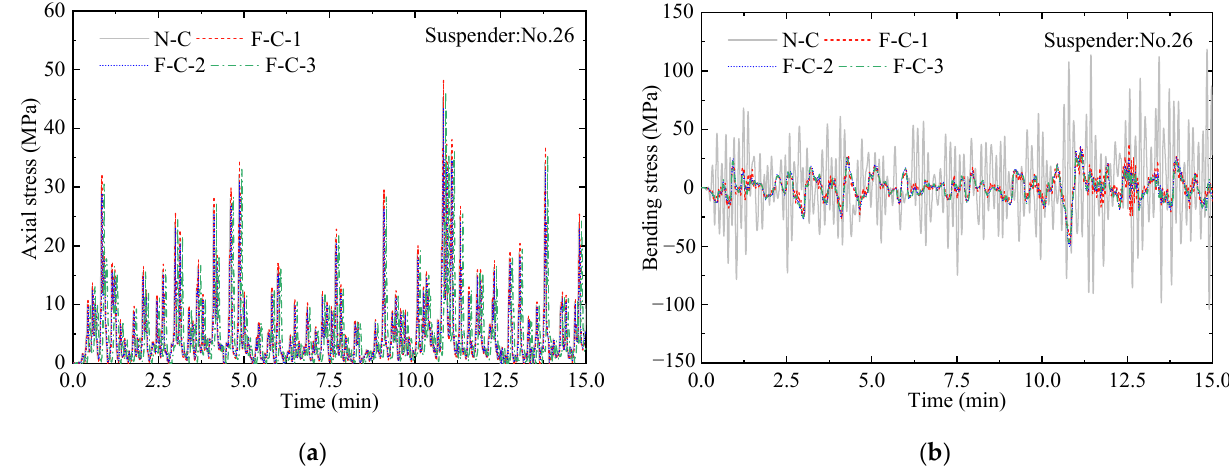
Figure 13. Time history of suspender stress (level 5). ( a ) Axial stress; ( b ) bending stress. Figure 14 shows the peak values of bending stress and axial stress. The suspender stress response under different traffic flows is different, and the axial stress is slightly in- fluenced by different traffic flows, whereas the bending stress is greatly reduced by flexi- ble central buckles. The settlement of flexible central buckles has a certain influence on the axial stress and bending stress of short suspenders. The axial stress peak values vary un- der different conditions. F-C-1 has an improvement effect on suspender no. 26, whereas F-C-2 has an improvement effect on suspender no. 25; these results are related to the po- sition of buckles. The settlement of buckles shares the axial stress of the suspender be- tween inclined cables. In terms of bending stress, the flexible central buckle can remarka- bly reduce the peak value of short suspenders, but the weakening effect is not significantly improved with the increase in the number of buckles. ( a ) ( b ) Figure 14. Comparison of peak values of stress. ( a ) Axial stress; ( b ) bending stress. The generation of pitting corrosion is a random process, and the maximum pitting depth directly affects the generation of cracks and fatigue life. In order to reflect the dif- ference in steel wire life, the corrosion fatigue degradation of steel wire under different working conditions was simulated. A total of 150 samples for each analysis condition were sampled based on randomly generated maximum pitting coefficients, and then the tran- sition from pitting corrosion to cracking and the crack development were calculated on the basis of the proposed predicting process. Figure 15 shows the crack development of the steel wire samples of suspender nos. 21–26. Under the N-C condition, the average